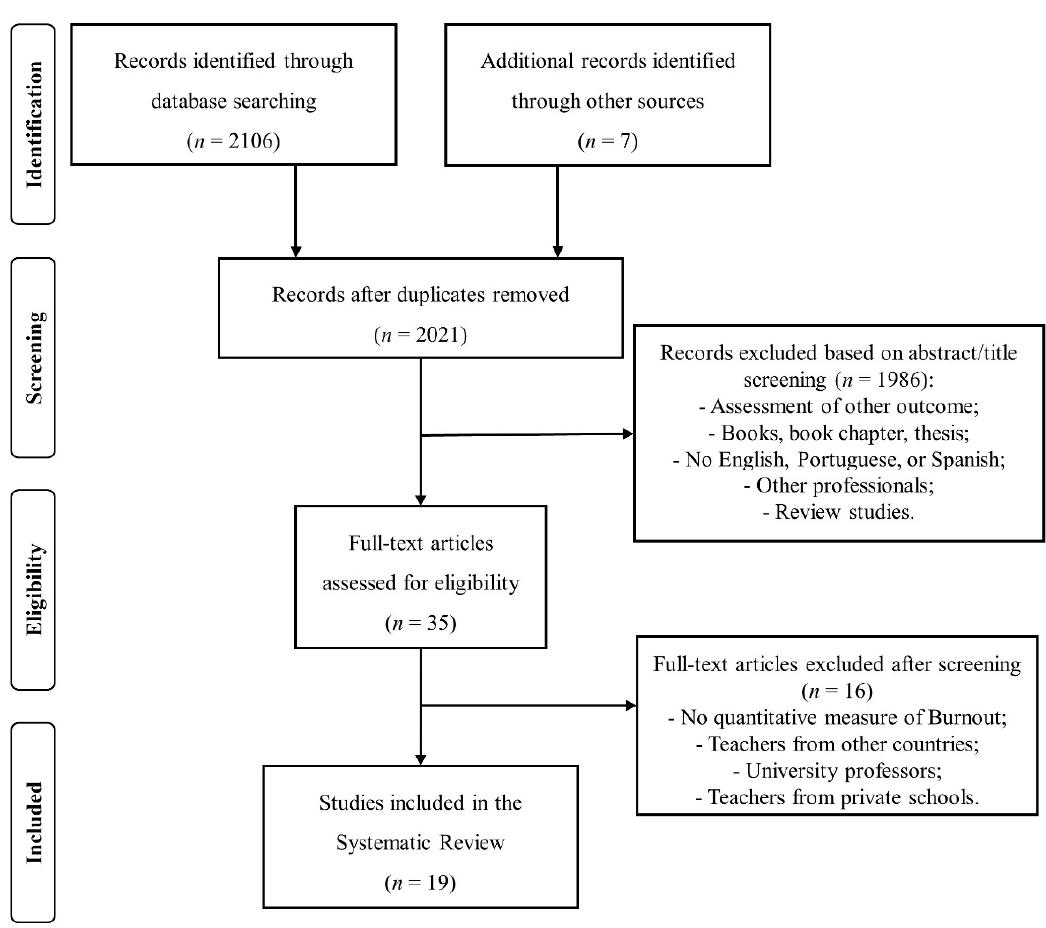
Figure 1. Flow diagram of the process of study selection.